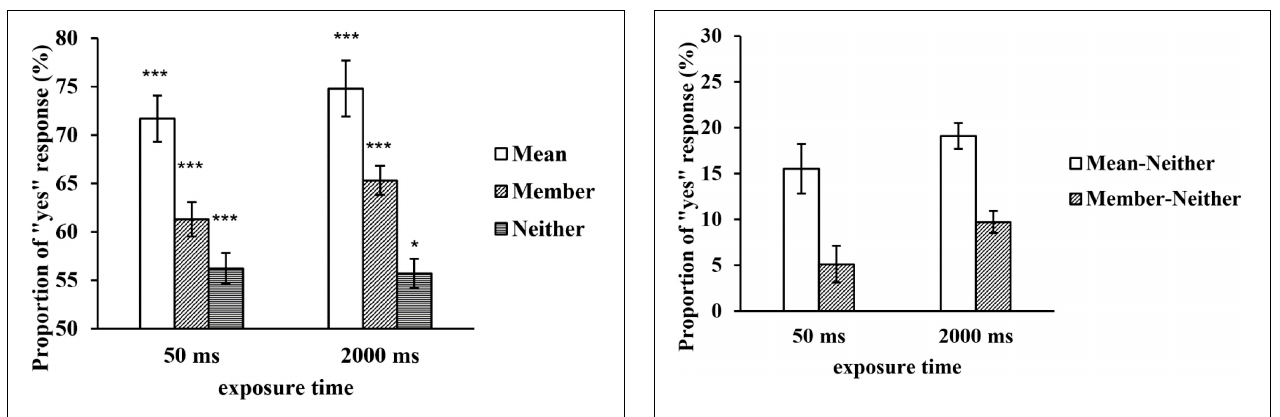
level ( t Mean = 11.257, p < 0.001; t Member = 8.481, p < 0.001;